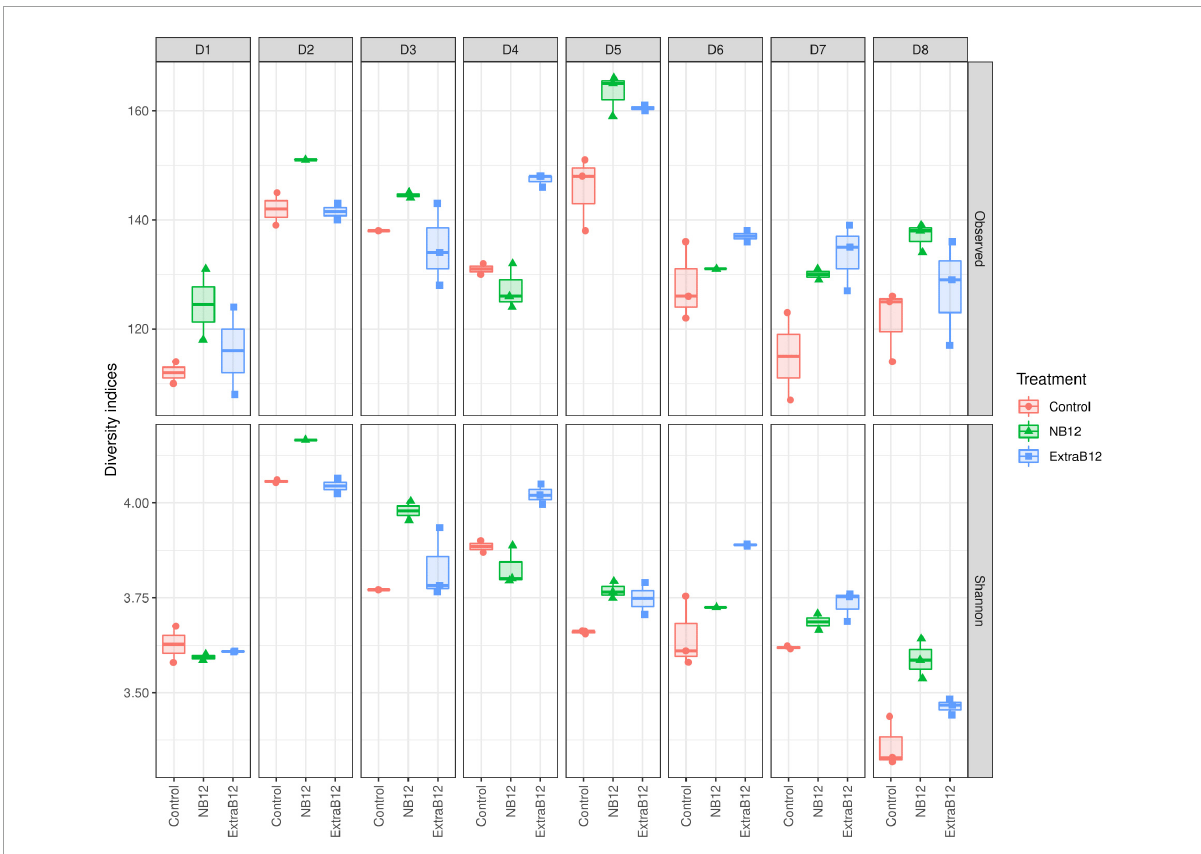
FIGURE4 Alpha diversity of fecal microbial communities of eight donors (D1–D8) after 24 h batch fermentation in Control, NB12, and ExtraB12 conditions. Boxplot of alpha diversity of the bacterial communities in the fermentation samples by means of Observed ASVs (upper panel) and Shannon (lower panel) indexes. The interquartile ranges and boxes, medians (lines in the boxes), and lowest and highest values for the first and third quartiles are presented. Each color represents one treatment as indicated in the